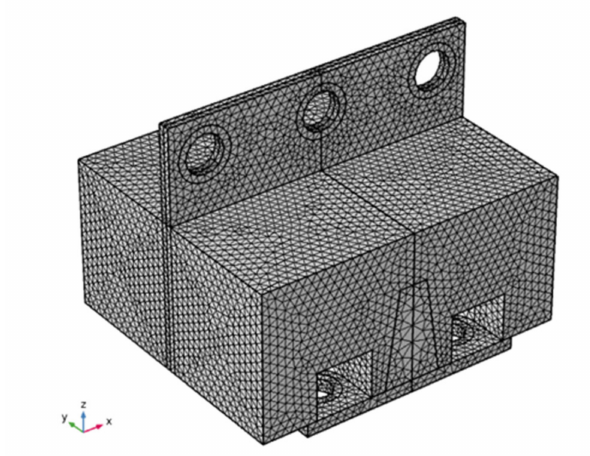
Figure 8. Discrete mesh diagram.